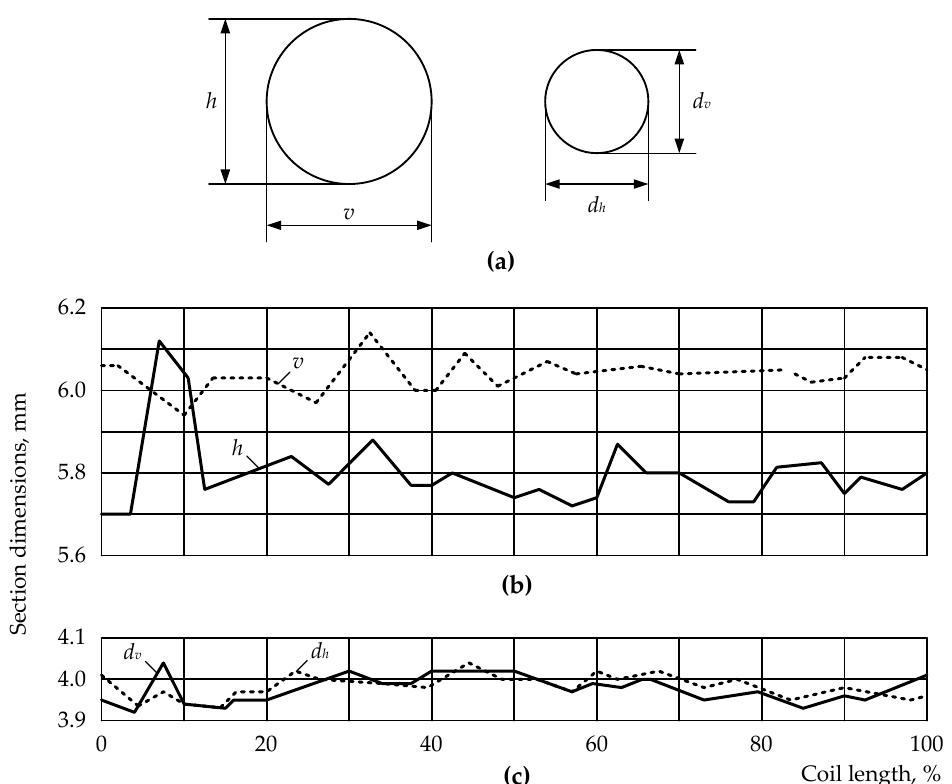
Figure 10. The Circumscribed and Inscribed Circles Explaining the Changes in the Workpiece Diameter ( a ); The Longitudinal Geometry Variation Measurement Results for rhe Initial Billet ( b ) and Wire ( c ). Steel R6M5: Section Dimensions, mm; Coil Length.